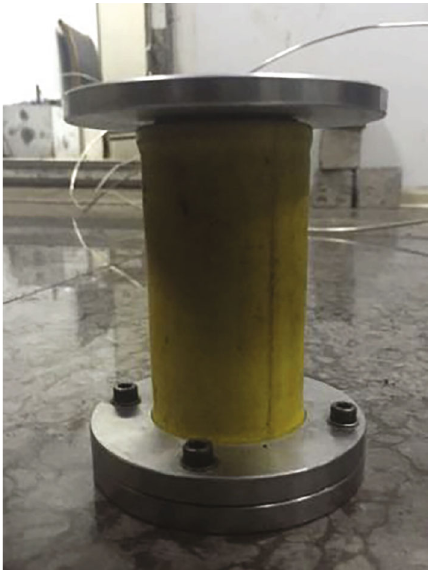
Figure 2: The packaged sample.